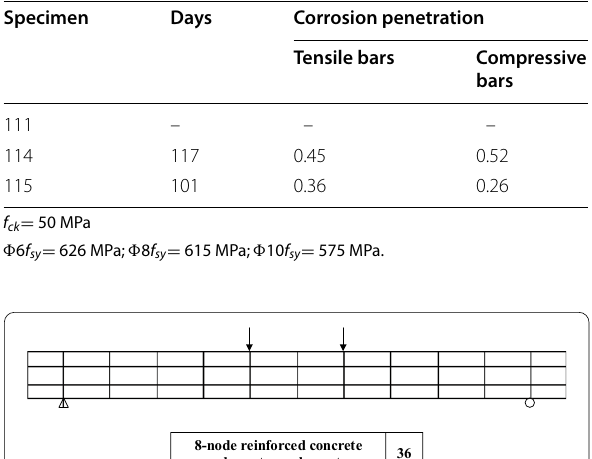
Table 1 Properties of deteriorated test specimens.